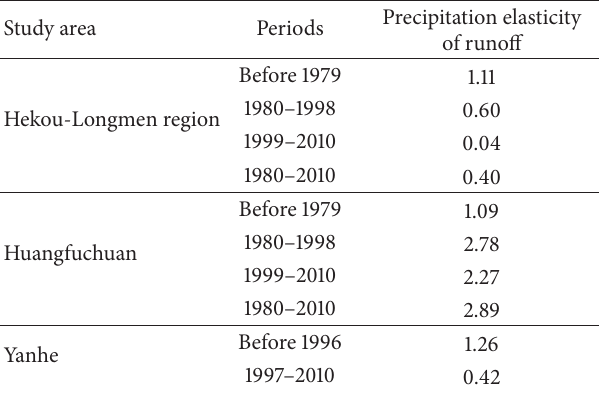
Table 3: Estimation of precipitation elasticity of runoff in the Hekou-Longmen region, Huangfuchuan, and